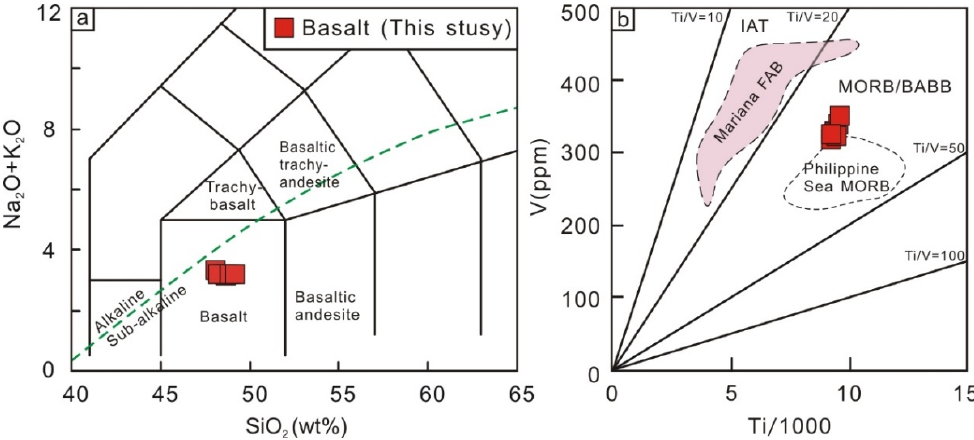
Figure 3. Geochemical diagrams of basalts from CBF in WPB: ( a ) SiO 2 vs. total alkalis (Na 2 O + K 2 O) diagram of Reference [23]. The alkaline–subalkaline boundary is from Reference [25]. ( b ) The V vs. Ti/10 3 diagram is from Reference [24]. The Marianna FAB are from Reference [26], and the Philippine Sea MORB are from References [4–9]. Abbreviations (in alphabetical order): BABB: back-arc basin basalt, FAB: fore-arc basalt, IAT: island arc tholeiite, and MORB: mid-ocean ridge basalt.